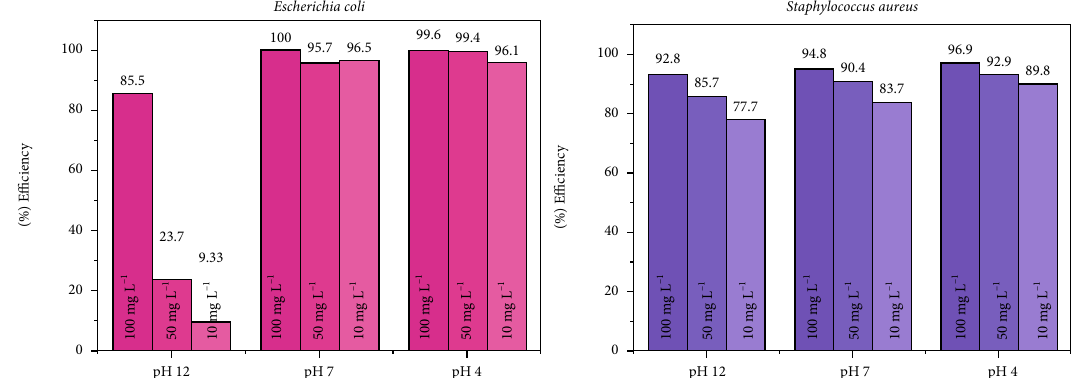
Figure 5: Microbiological e ffi ciency of TiO NPs in contact with Escherichia coli (Gram-negative) and Staphylococcus aureus 2